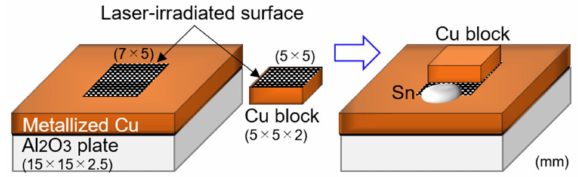
Figure 2. Illustration of the process used for joining